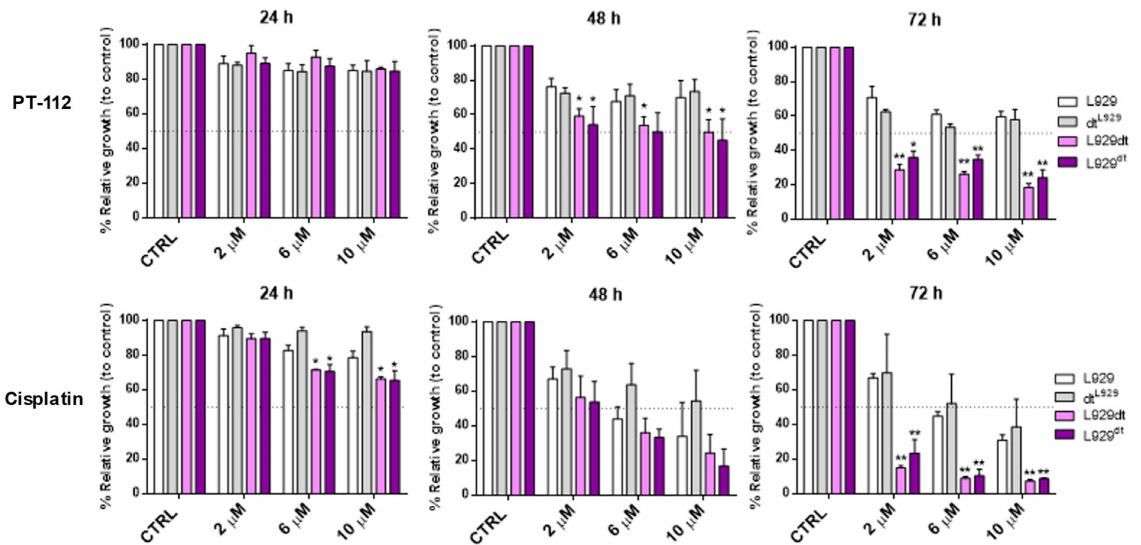
Figure 1. Cell growth analysis after treatment with PT-112 or cisplatin, as indicated. Cells were treated with increasing concentrations of PT-112 or cisplatin, incubated for 24–72 h, and cell growth was measured by the MTT assay. Results were expressed as the percentage of relative growth compared to control, untreated cells (CTRL) ± SD of at least 2 independent experiments performed in duplicate. Statistical significance represents those values in which cell growth inhibition by the drugs was higher in a given cell type as compared with parental L929 cells. *, p < 0.05; **, p <